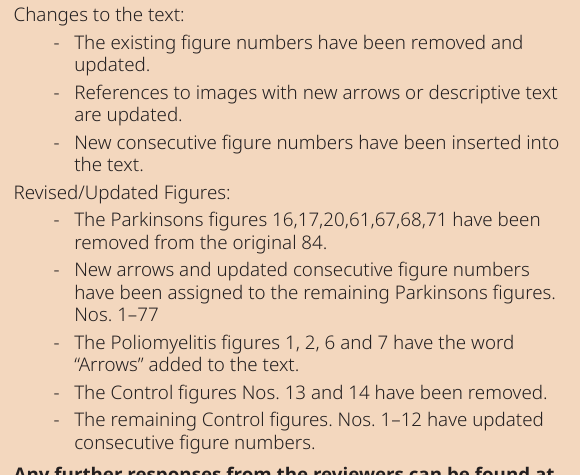
bodies (arrows) and external inclusion bodies are shown. plasmic inclusion body in a PD neuron in the same case, image 2.13b031. Many VLP are shown. (arrows) Parkinson’s Figure 6. High magnification of a cyto- plasmic inclusion body in a PD neuron in the same case, image 2. 13b033. Many VLP are